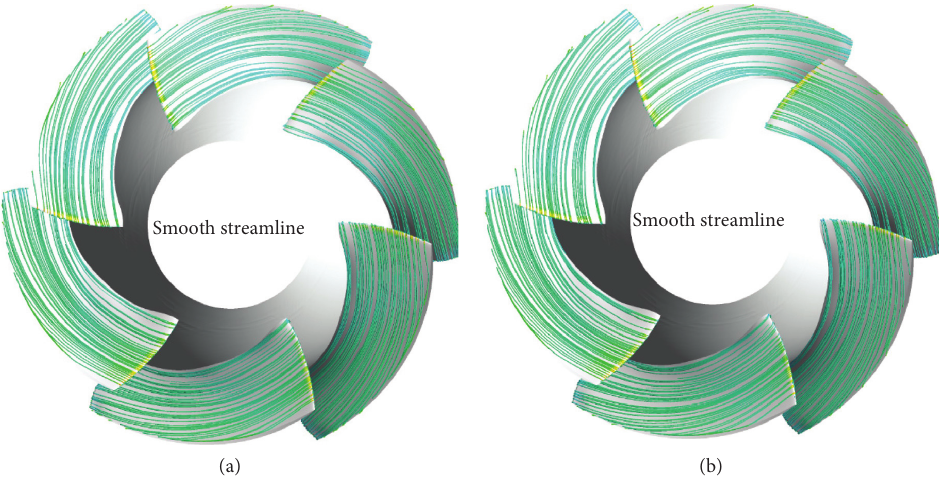
Figure 13: Streamlines on blade under 1.0 Q ′ condition: (a) original scheme; (b) selected scheme.